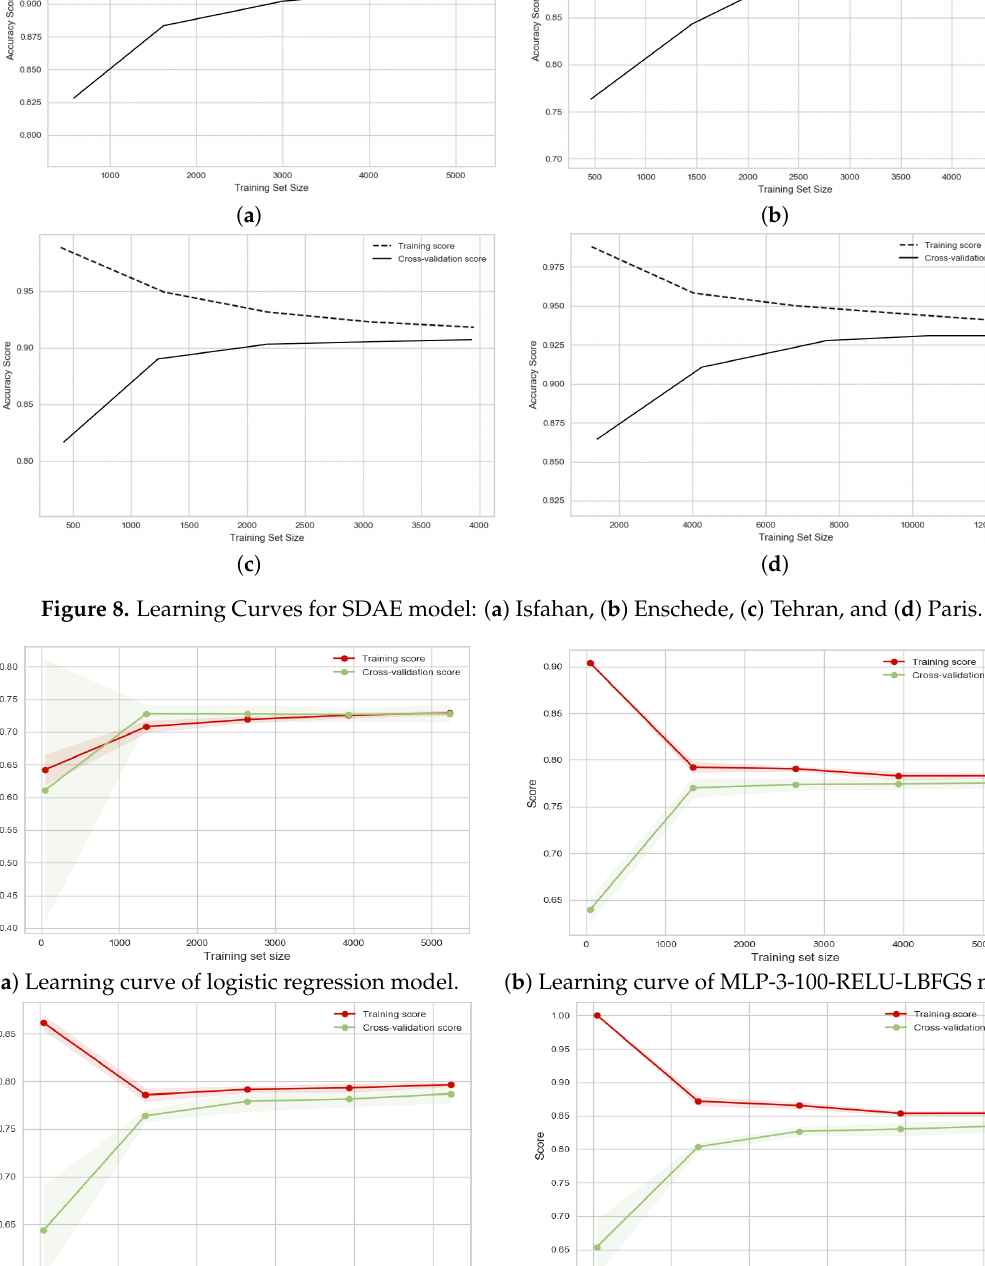
( a ) Learning curve of logistic regression model.